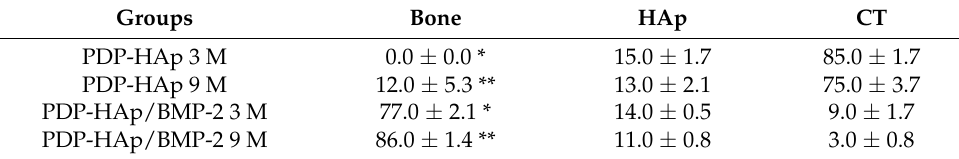
Table 1. The changes in proportion (%) of each tissue to total volume of implant.